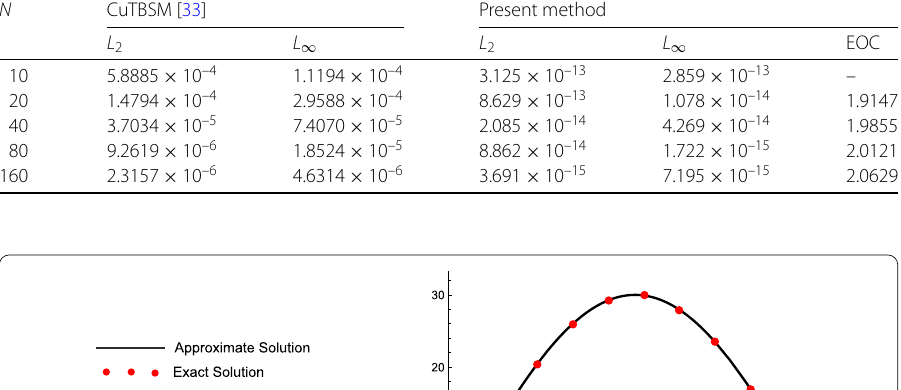
Table 4 Error norms L 2 and L ∞ and EOC for Example 1 when (cid:11) t = 1 N